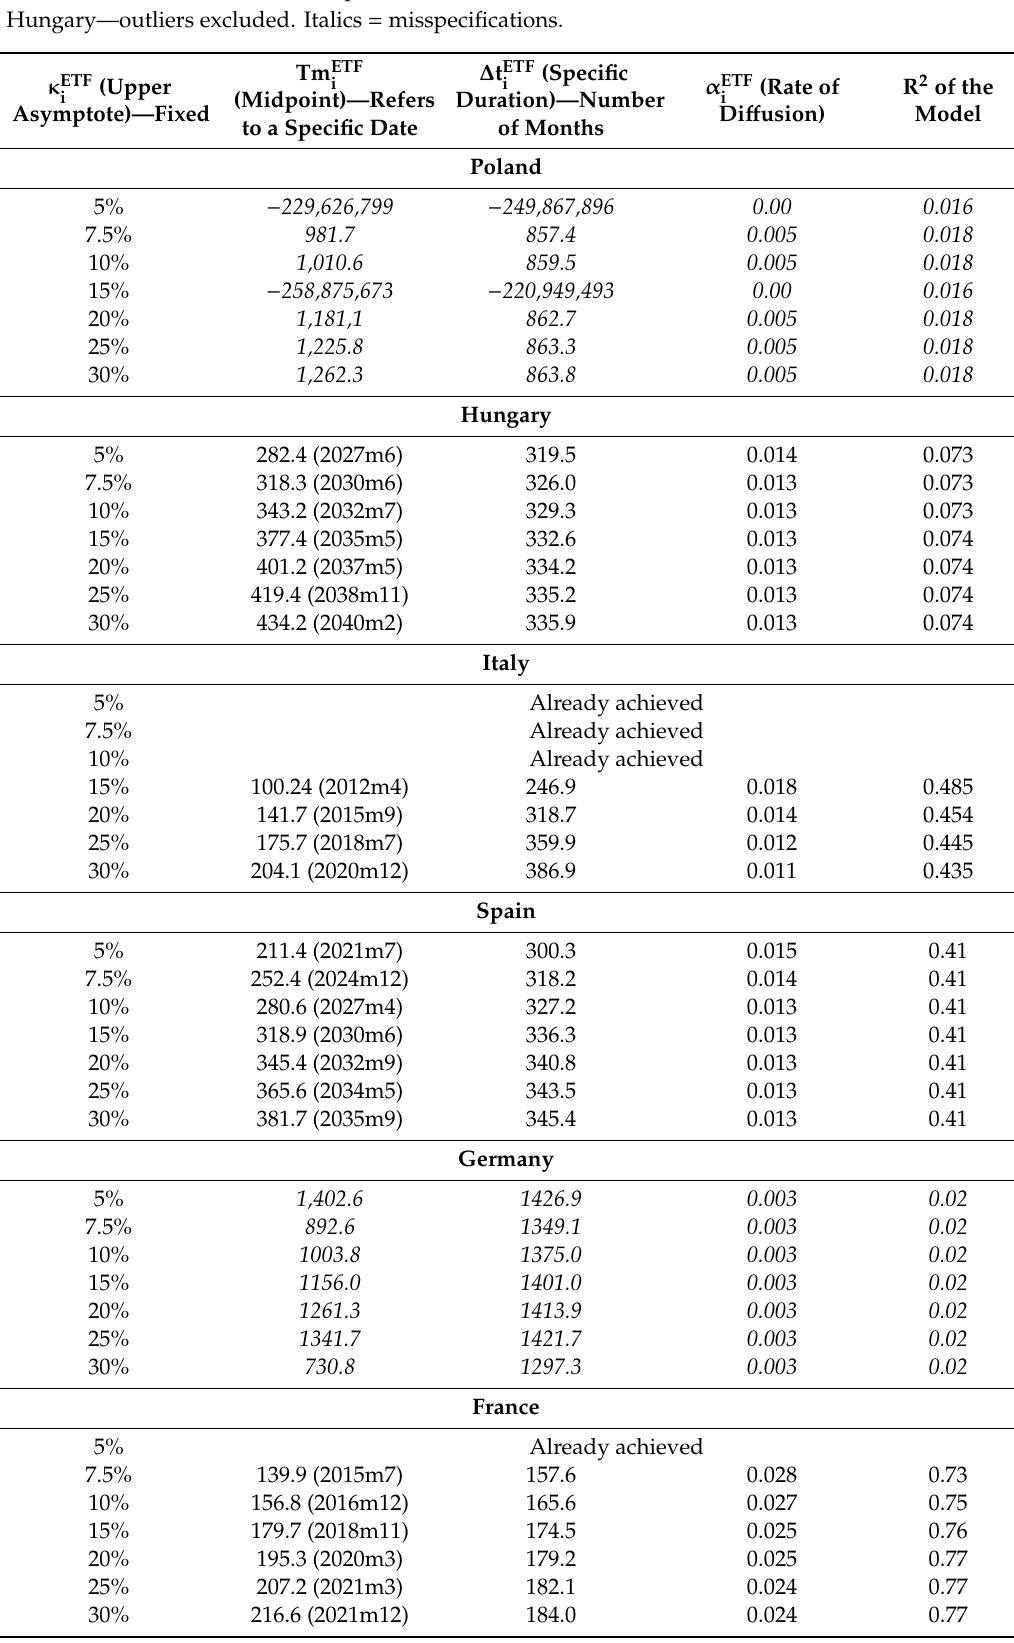
Table 4. Predicted ETFs di ff usion patterns (as share of total turnover of index financial instruments). Hungary—outliers excluded. Italics =